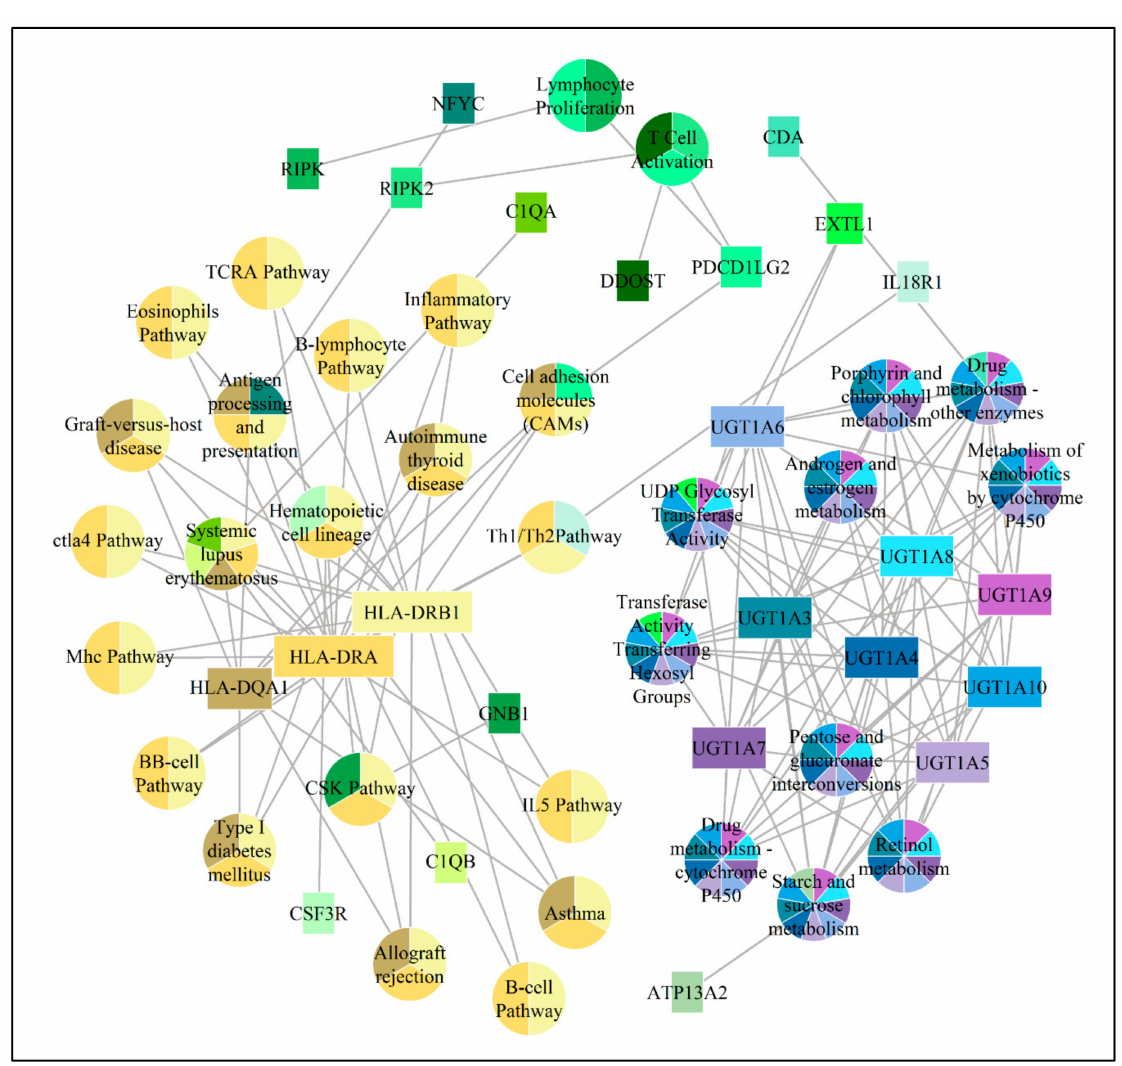
Figure 2. Network of genes associated with enriched pathways. Square and circular nodes represent the genes and enriched pathways respectively. Size of square node is proportional to the number of pathways associated with each gene. The circular node is segmented into colored pies to illustrate the associated genes with each pathway. Human leukocyte antigen (HLA) and UDP glucuronosyltrans- ferase (UGT) genes are colored respectively with shades of yellow and blue. Remaining genes are indicated in shades of green. Edge represents a gene-pathway association. The network was created using igraph R package